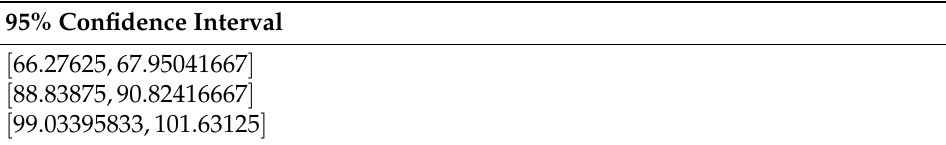
Table 7. Heart rate 95% confidence intervals for each of these three